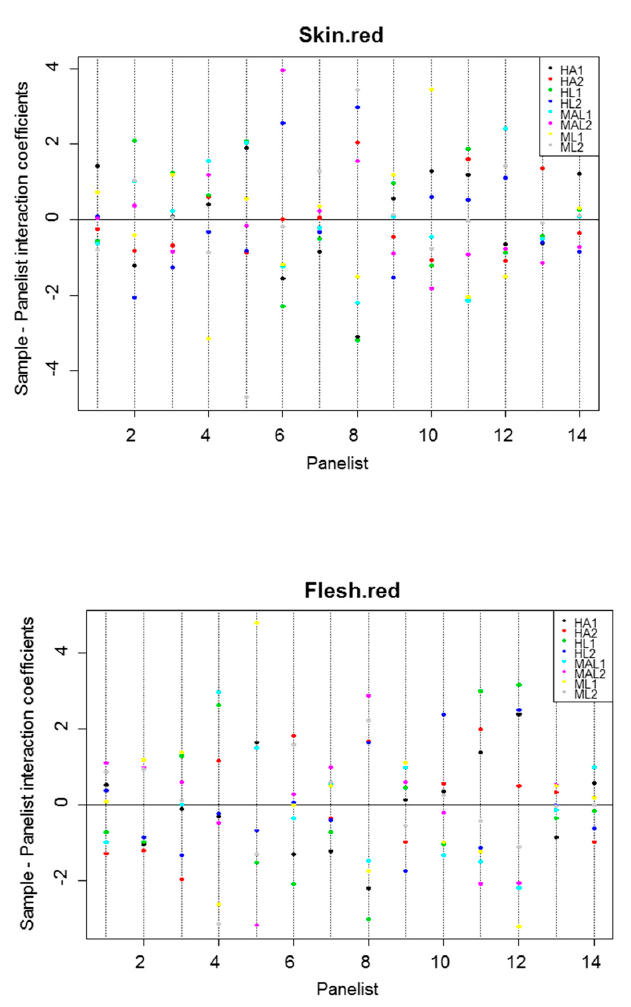
Figure 1. Panel performance. Sample·panelist interaction coefficients for selected descriptors (skin red and flesh red).